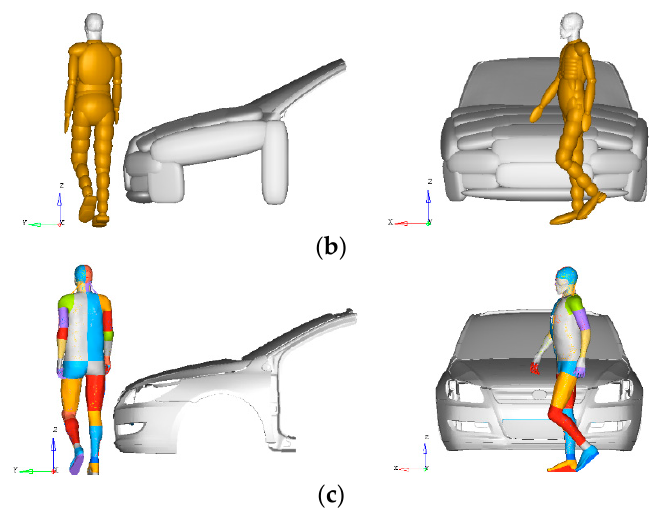
Figure 9. Initial conditions of car-to-pedestrian impact scenarios: ( a ) full-scale TNO multibody (MB) pedestrian model, ( b ) CPCBM, ( c ) full-scale Total Human Model for Safety (THUMS) finite element (FE) pedestrian model. Table 4. Comparison of the computation time needed by different models.